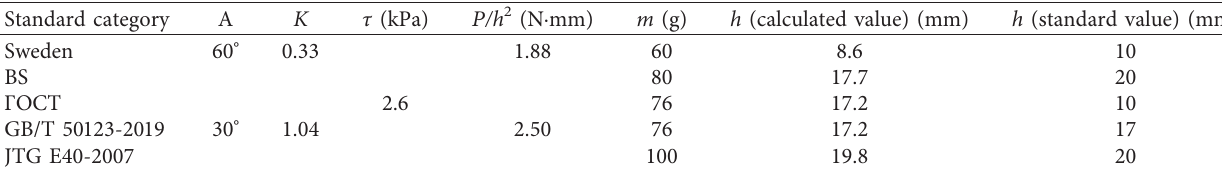
Figure 7: The influence of different cone angle α on resistance to shear strength τ at the same P /h 2 value. Table 3: P - h diagram with different standard cone